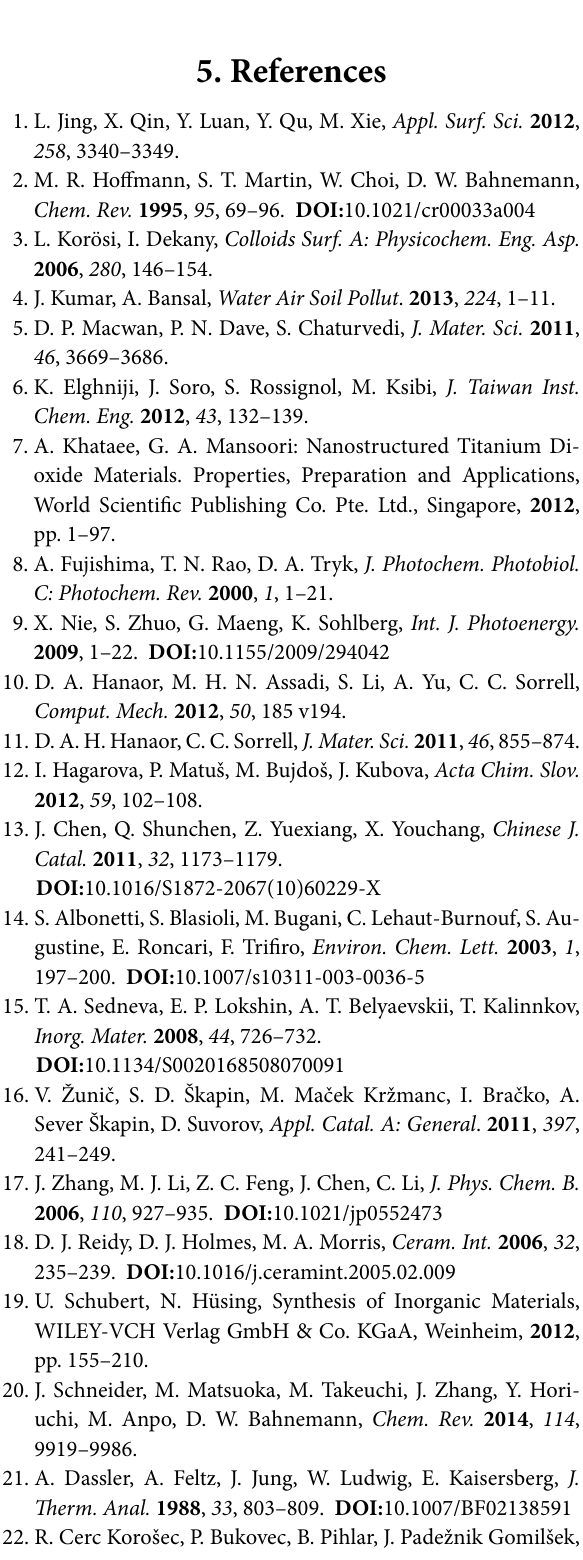
Table 3. The proportion of added and measured dopant in doped powders and thin films. TiO 2 The amount of The amount Form of